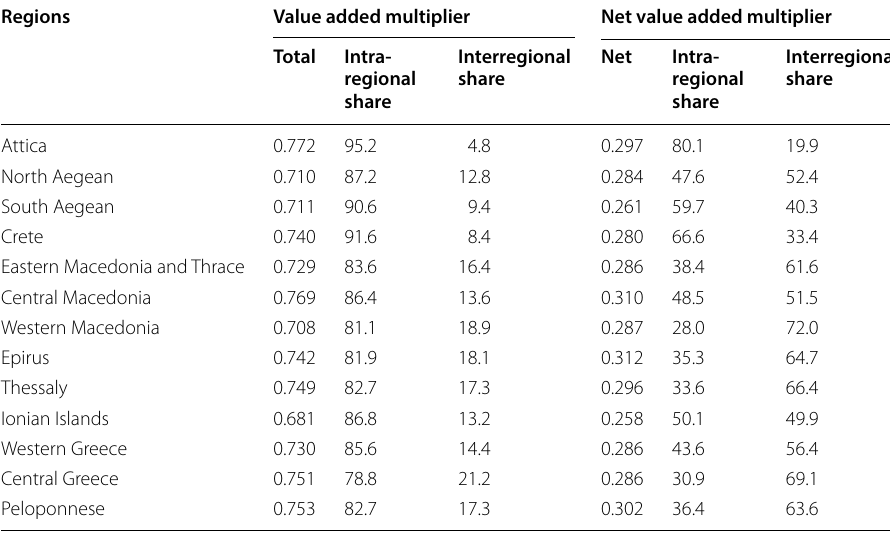
Table 2 Regional distribution of the average total value-added multipliers: Greece, 2013 (in %). Source: Calculations by the authors